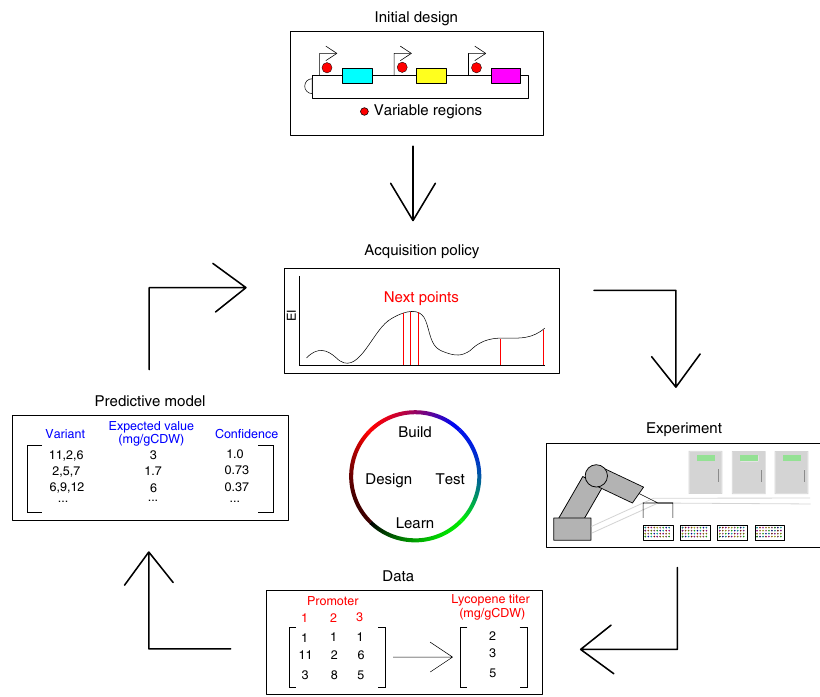
Fig. 1 The overall work fl ow of BioAutomata. After setting the initial parameters, designing the sequence space of variable regions (such as promoter variants in a combinatorial pathway assembly), and de fi ning the objective function, BioAutomata selects which experiments are expected to result in the highest improvement of yield, performs those experiments, generates data and learns from it, updating its predictive model given the newly presented evidence. It will then decide on the next experiments to perform to reach the goal set by the user while trying to minimize the number of experiments